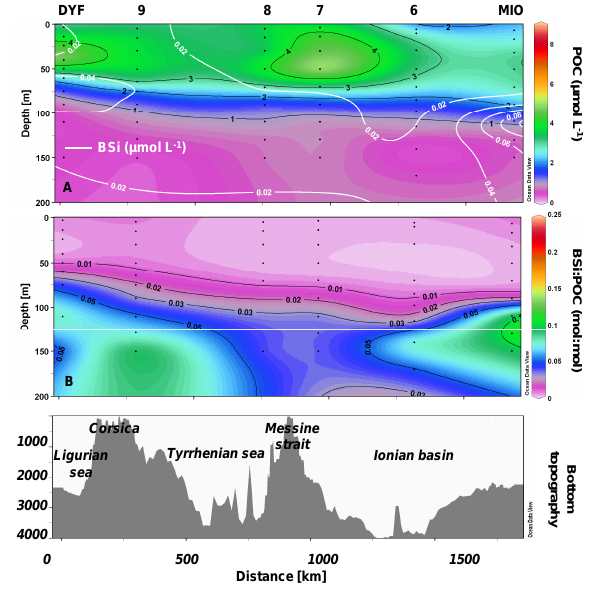
(A) Distribution of particulate organic carbon (POC) (µmolL − 1 ) , with BSi concentrations (µmolL − 1 ) isopleths as over- lays in white and (B) BSi:POC ratios (mol:mol) along transect 2 during the PROSOPE cruise (summer/fall 1999).